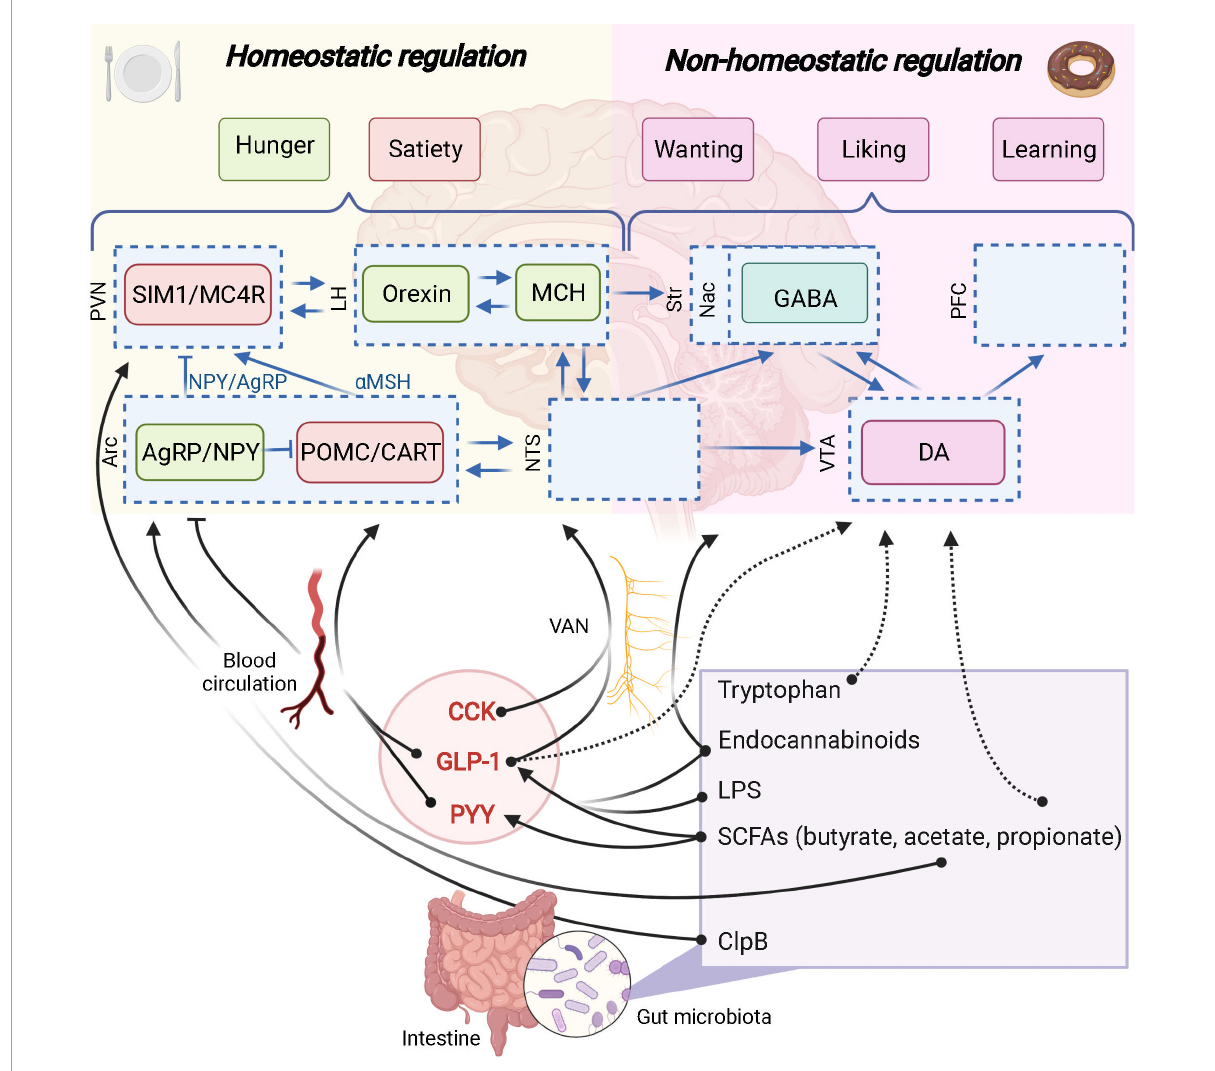
FIGURE3 The role of the gut microbiota in homeostatic and non-homeostatic controls of food intake. Potential links are represented in dashed arrows. Demonstrated links are represented in solid arrows. PVN, paraventricular nucleus; SIM1, single–minded family BHLH transcription factor 1; LH, lateral hypothalamus; Str, striatum; Nac, nucleus accumbens; GABA, γ -aminobutyric acid; PFC, prefrontal cortex; Arc, arcuate nucleus; AgRP, agouti-related protein; NPY, neuropeptide Y; POMC, pro-opiomelanocortin; CART, cocaine-amphetamine-related transcript; NTS, nucleus tractus solitarus; VTA, ventral tegmental area; DA, dopamine; VAN, vagal afferent nerves; CCK, cholecystokinin; GLP-1, glucagon-like peptide 1; PYY, peptide YY; SCFAs, short-chain fatty acids; LPS, lipopolysaccharide; MC4R, Melanocortin 4 receptor. Created with